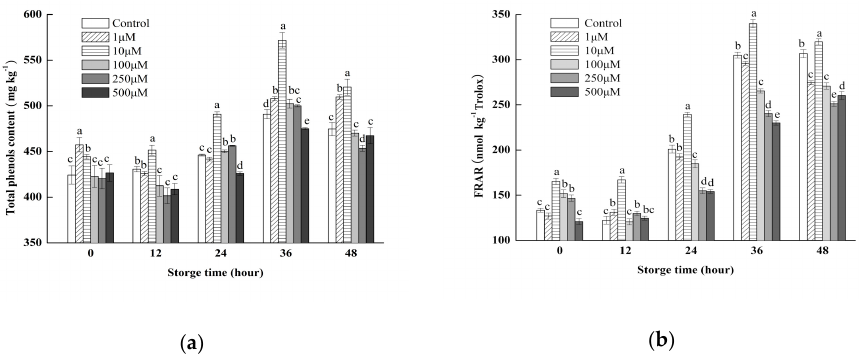
Figure 1. E ff ect of treatments with di ff erent MeJA concentrations on total phenolics content ( a ) and ferric reducing antioxidant power (FRAP) ( b ) of broccoli during 48 h of storage at 20 ◦ C. Columns with vertical bars represent the mean ± SD ( n =